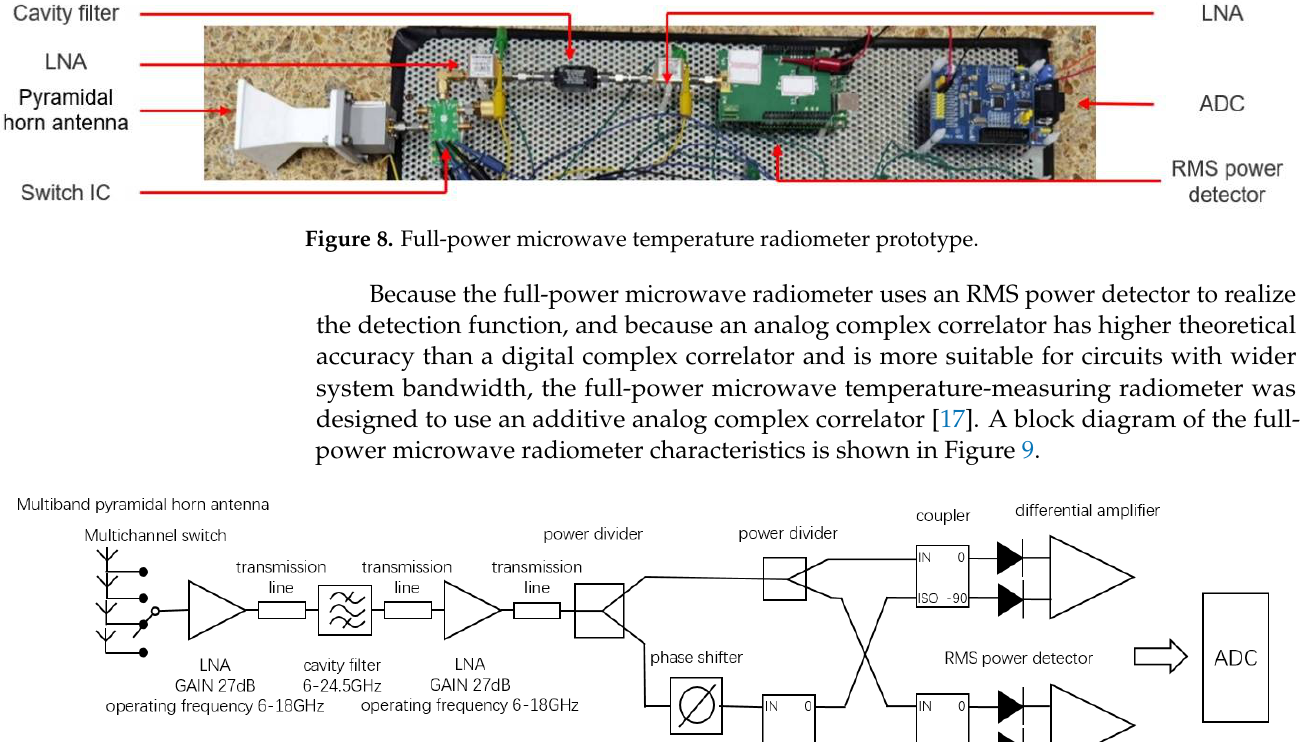
Figure 7. Block diagram of multiband full-power microwave temperature radiometer.